Question: Give a one-sentence summary of this figure.
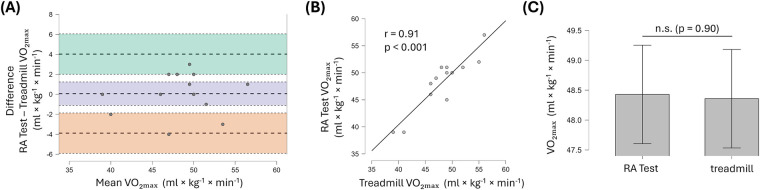
Answer: (A) Bland–Altman plots indicating mean difference and 95% limits of agreement between VO 2max elicited with the RA test and treadmill test, (B) Pearson's correlation scatterplot indicating a linear relationship between VO 2max elicited with the RA test and treadmill test, and (C) a paired samples t -test indicating the difference between the VO 2max values derived from the treadmill and RA test. Error bars indicate 95% confidence intervals.